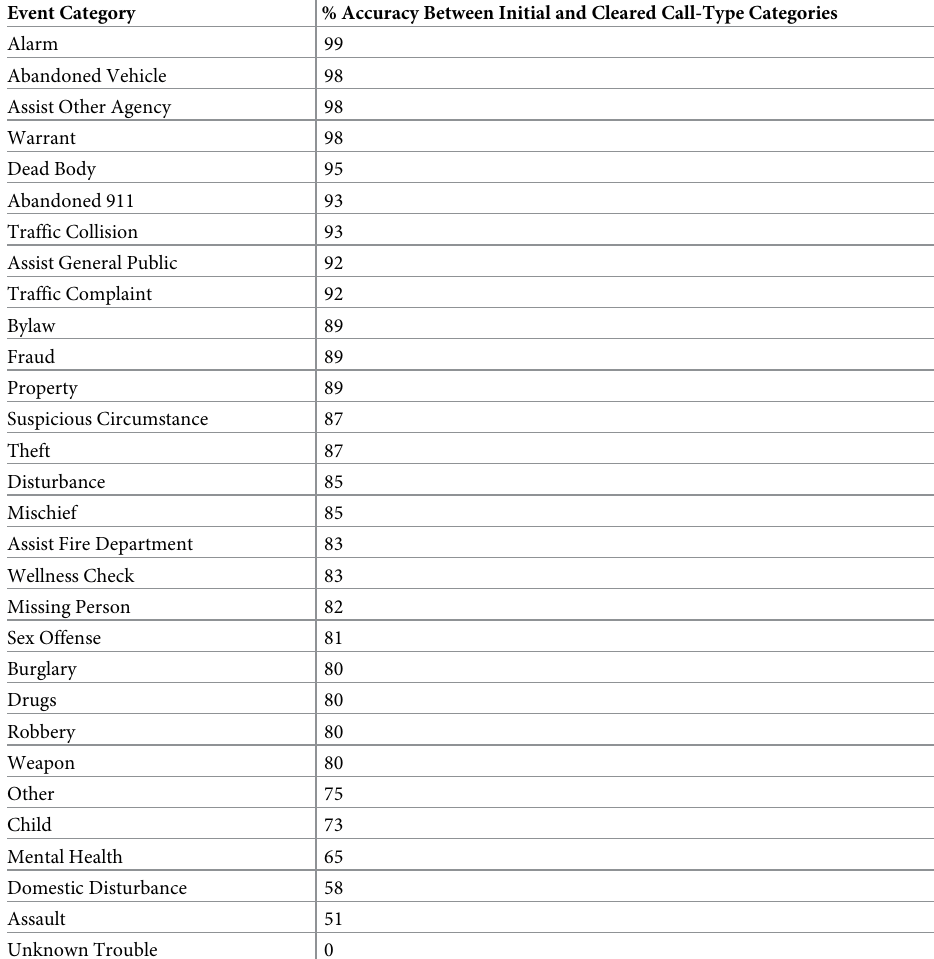
Table 2. Call-type categories and their classification accuracy